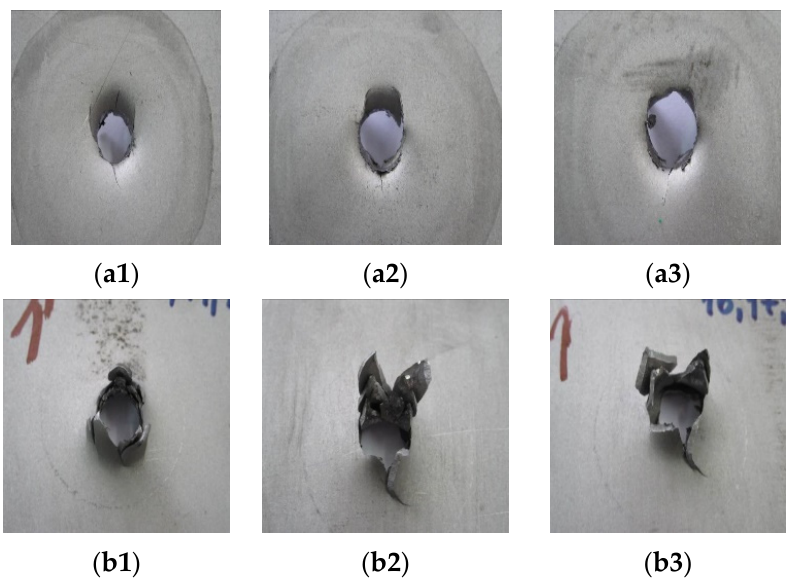
Figure 15. Results of dynamic impact tests of 1 mm Ti6Al4V sheet in layer structure of pairs: ( a1 – a3 ) view from above; ( b1 – b3 ) view from bottom.